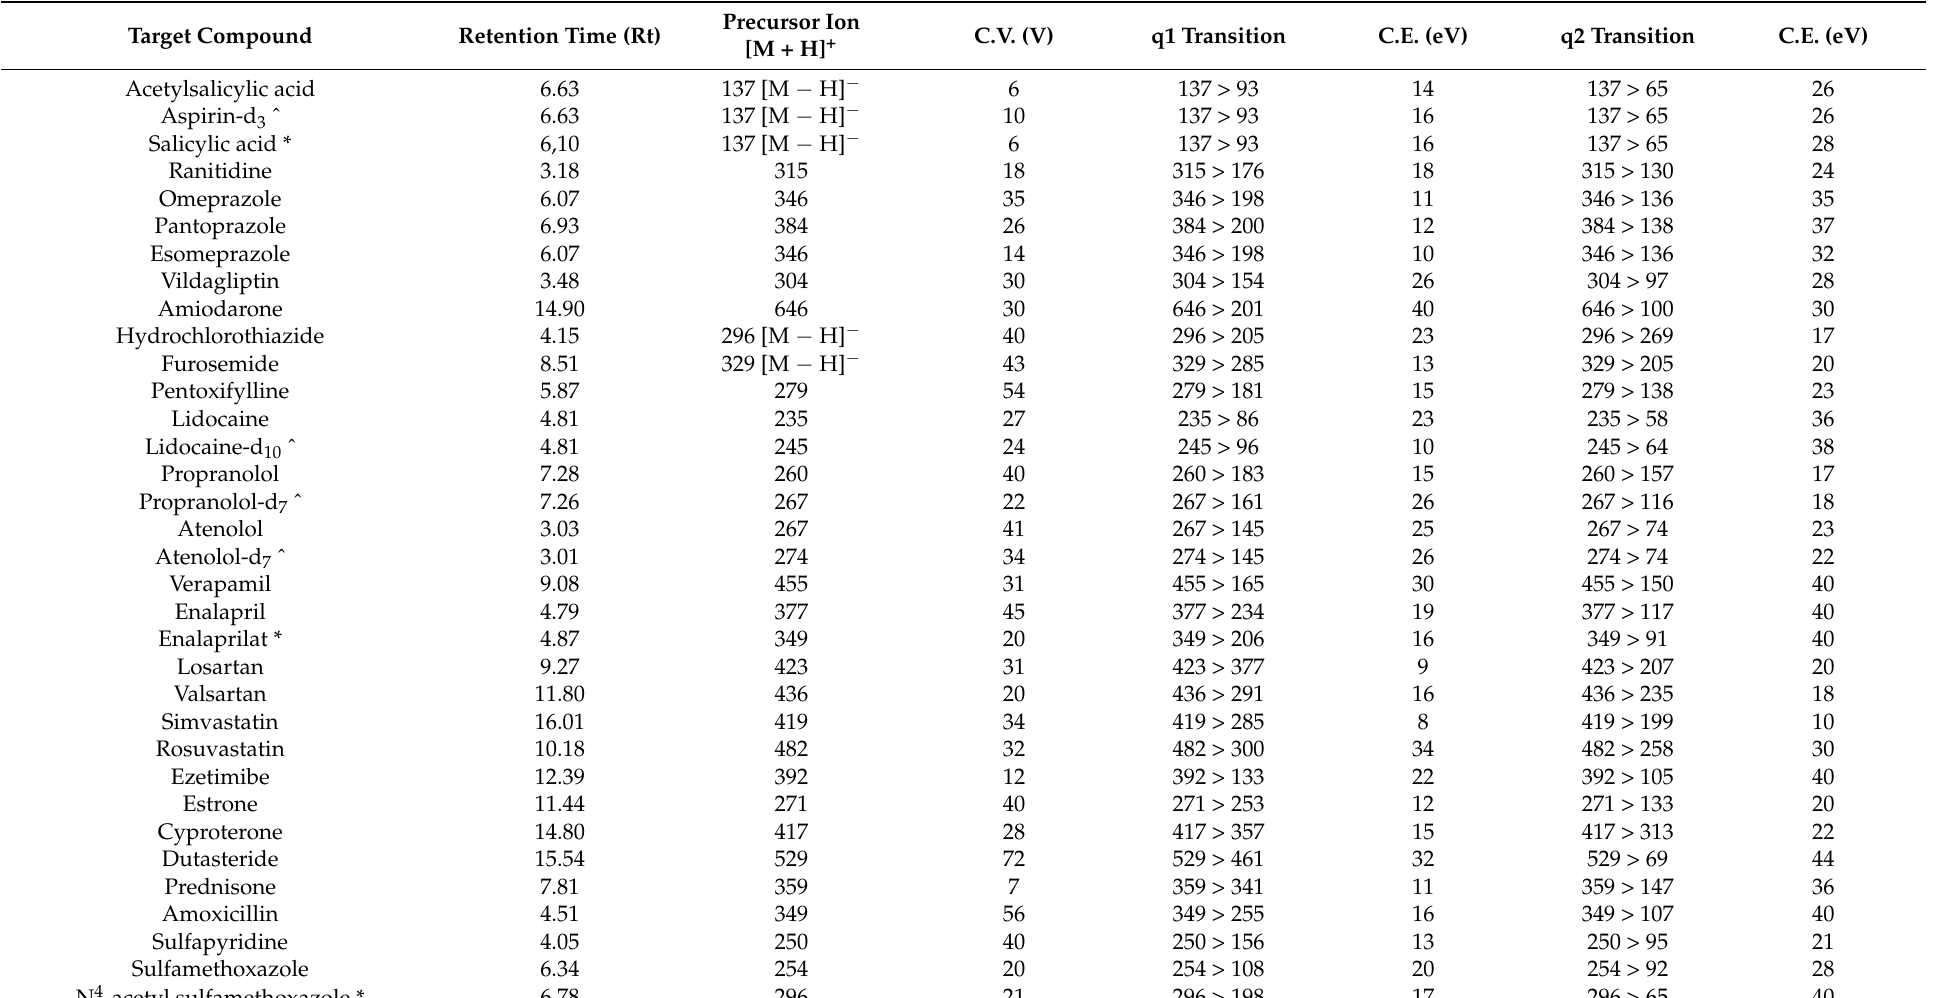
Table 1. LC-MS/MS optimized parameters for selected pharmaceuticals (ordered by ATC code), metabolites (*), transformation product (**), and their internal standards (ˆ). C.V.: cone voltage (V); C.E.: collision energy (eV); q1: product ion for quantification; q2: product ion for